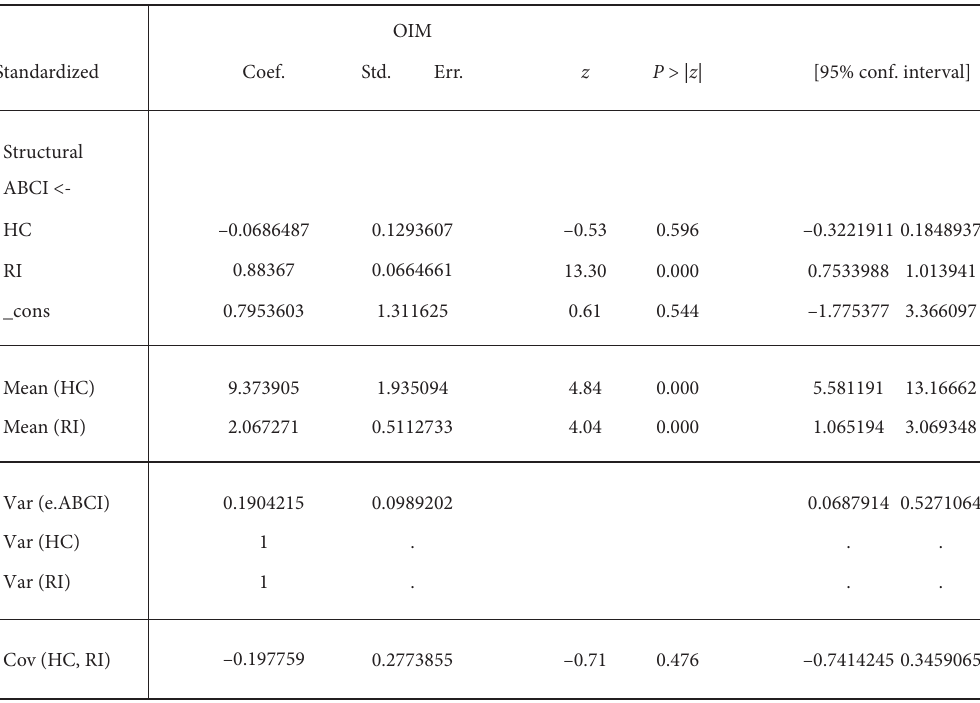
Figure 10: Tabular form of the magnitude of the effectiveness of RI and HC over ABCI as shown in Figure